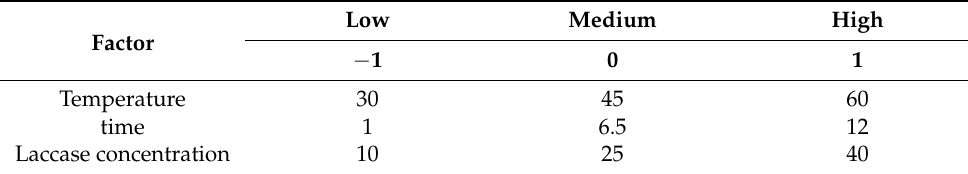
Table 1. Factors level for design a Box–Behnken experiment of delignification of rice straw. Low Medium High Factor − 1 0 1 Temperature 30 45 60 time 1 6.5 12 Laccase concentration 10 25